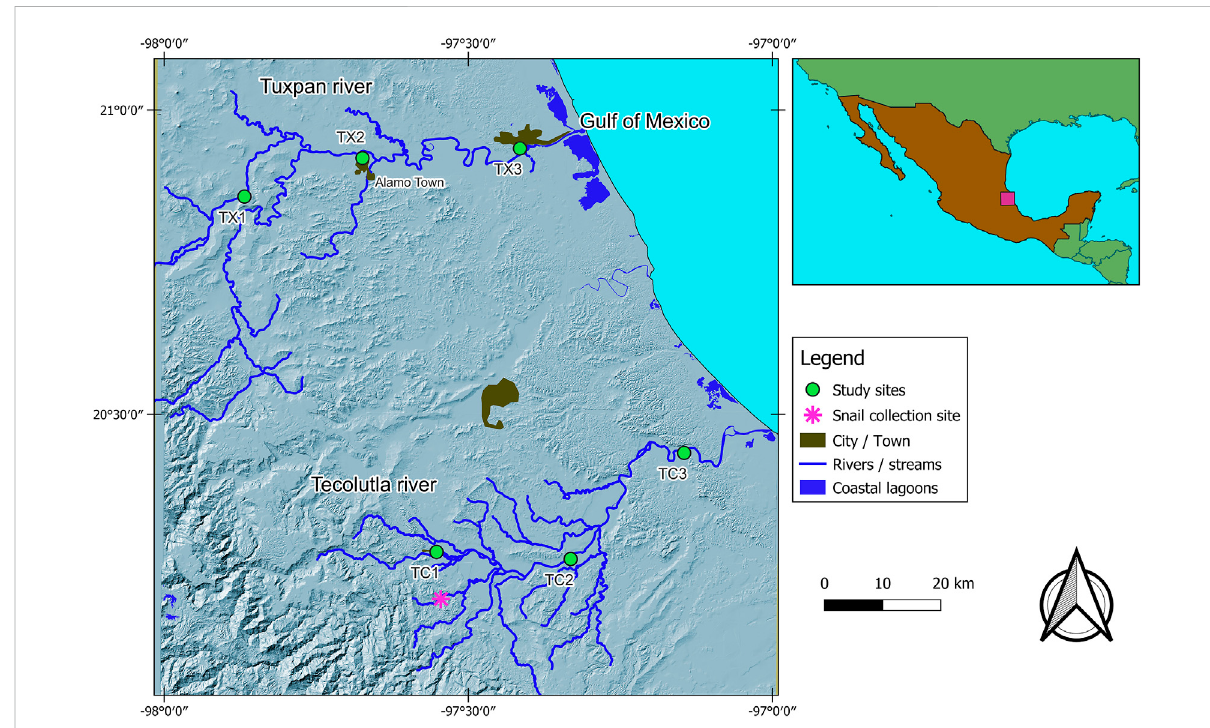
Study area, showing the location of study sites in both rivers and the collection site of sentinel